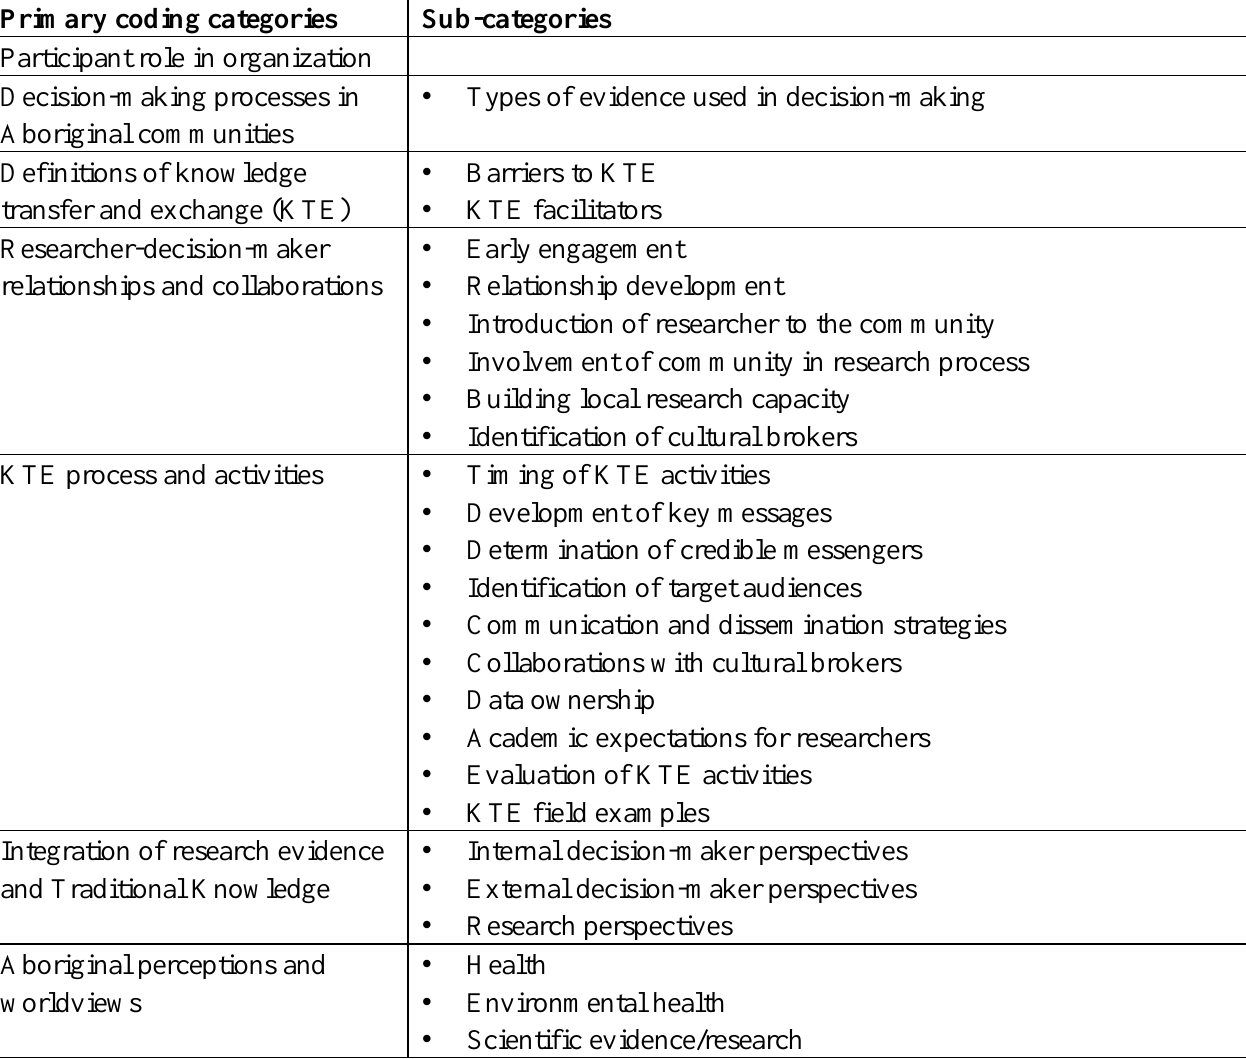
Table 1. Coding categories and